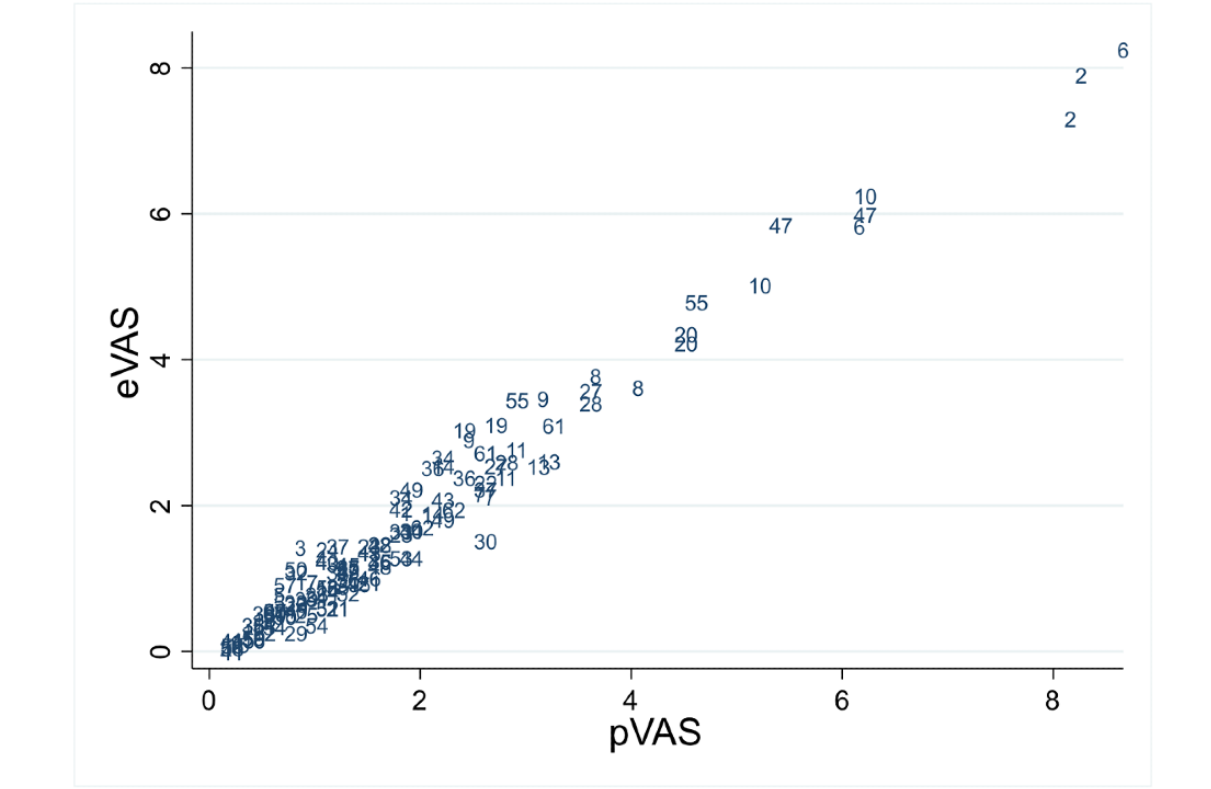
Figure 5. Scatter plot of the data in adults. Points are represented by subject number. eVAS: electronic visual analog scale; pVAS: paper visual analog